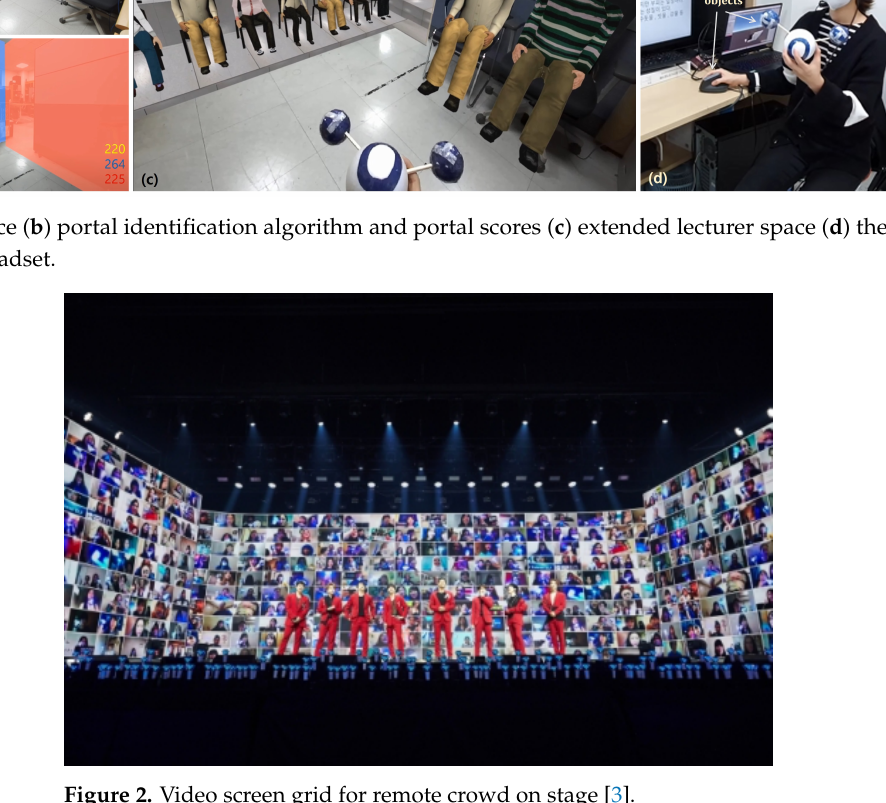
Figure 2. Video screen grid for remote crowd on stage